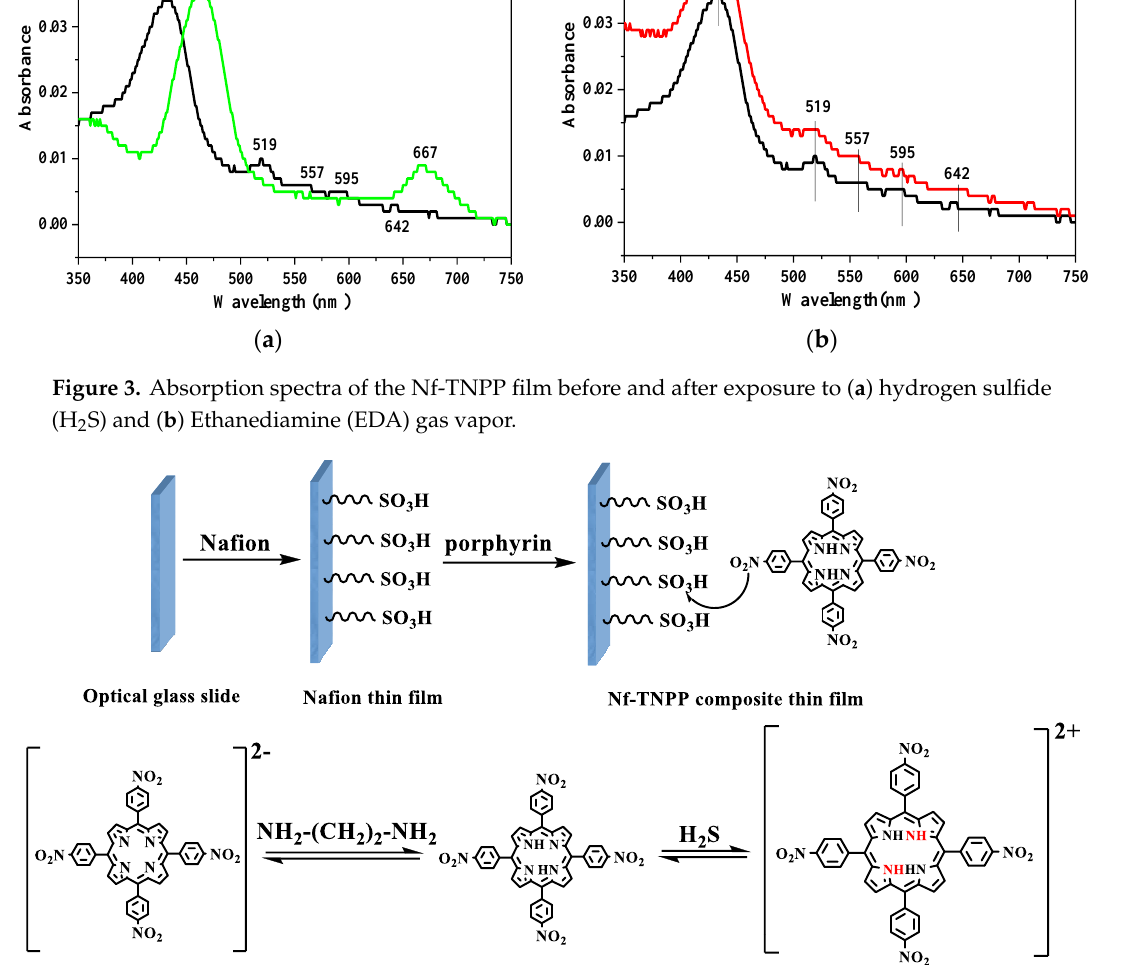
Scheme 1. Stepwise fabrication of the functionalized Nf-TNPP-composite thin film and